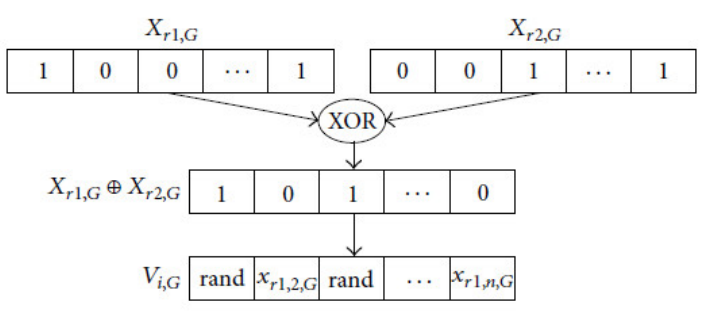
Figure 1. Dichotomous mutation example.